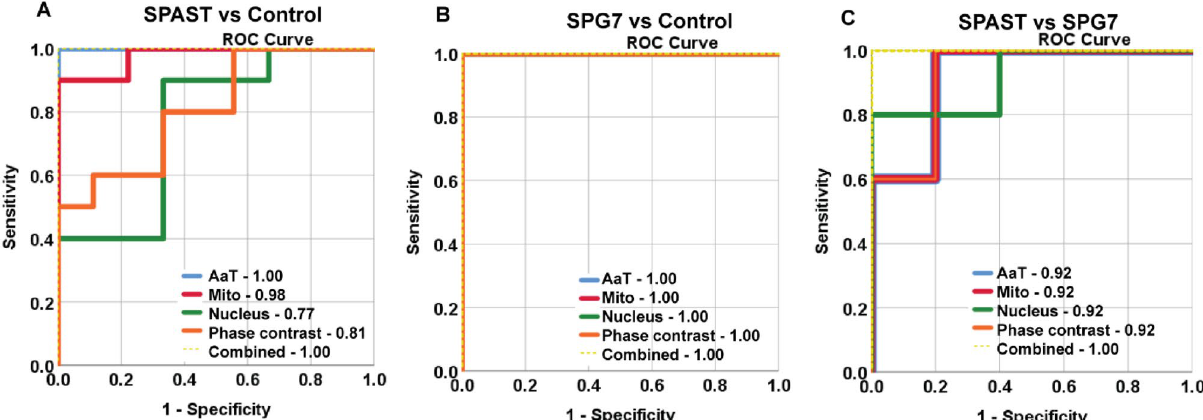
Figure 6. ROC curve analysis. ROC curve analysis of ( A ) SPAST vs control samples ( B ) SPG7 vs control samples ( C ) SPAST vs SPG7 samples. The AUC for all markers for SPG7 vs control samples is 1.00 and hence all lines overlap and cannot be distinguished. AUC is mentioned for all markers. AaT Acetylated α-tubulin, Mito Mitochondria, Nucleus, Cell phase contrast and Combined: All markers combined.